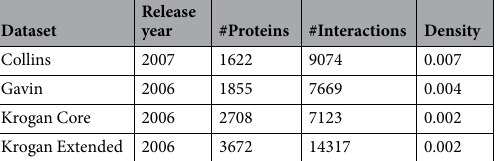
Table 1. Details of four PPI Network datasets used in the